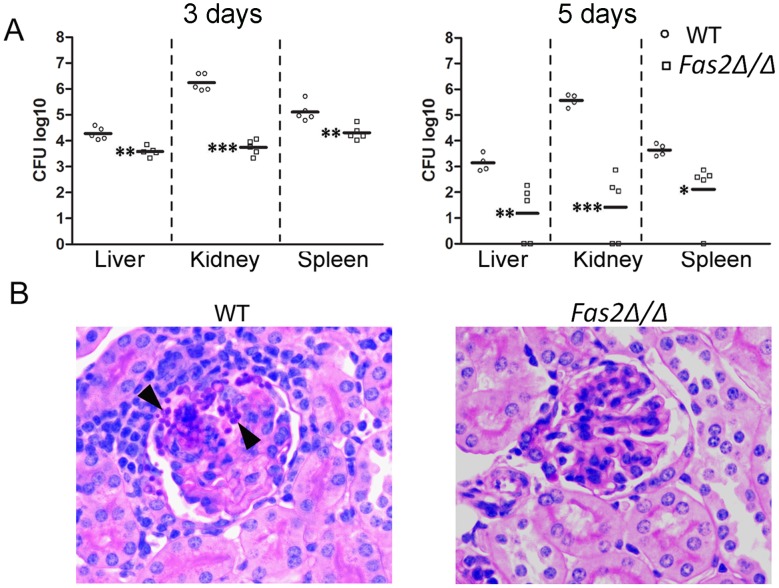

Fas2Δ/Δ yeast cells are attenuated in vivo.Intravenous infection of A/J mice with WT and Fas2Δ/Δ yeasts (C, D). A, shown are the CFUs from kidneys, spleens, and livers 3 and 5 days intravenous infection. Each symbol represents 1 mouse. *P≤0.05; **P≤0.01; ***P≤0.001, (Newman-Keuls). B, images shown are representative histological sections of kidneys 5 days after intravenous infection with WT and Fas2Δ/Δ strain, respectively. Arrowheads indicate aggregates of yeast cells in WT infected tissues. Initial magnification ×400.